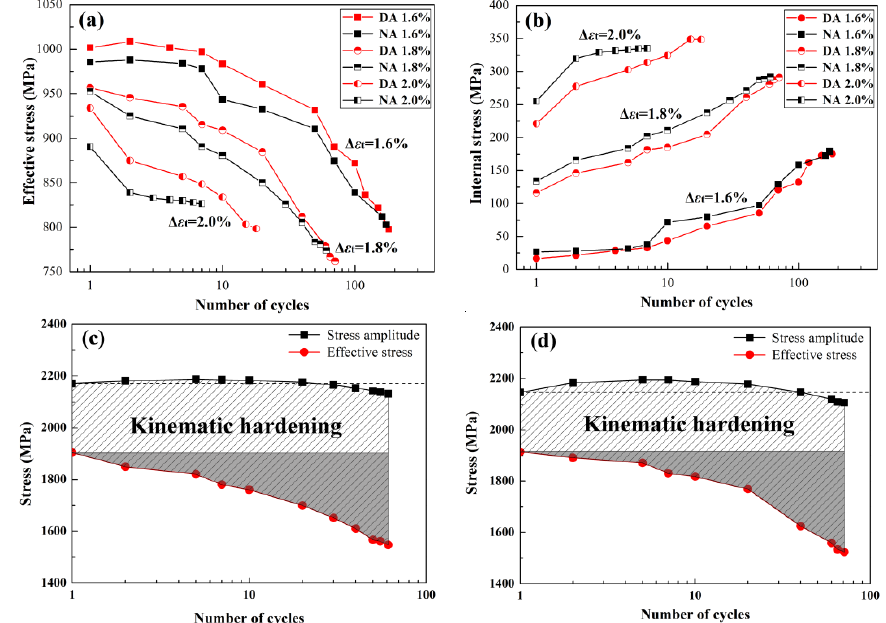
Figure 13 . Effective stress ( a ); and internal stress ( b ) of NA alloy and DA alloy as a function of number of cycles at different total strain. Evolution of kinematic hardening effect with number of cycles of NA ( c ) and DA ( d ) alloy at total strain amplitude of 1.8%. The kinematic hardening is indicated by shading while the isotropic softening is displayed by the gray